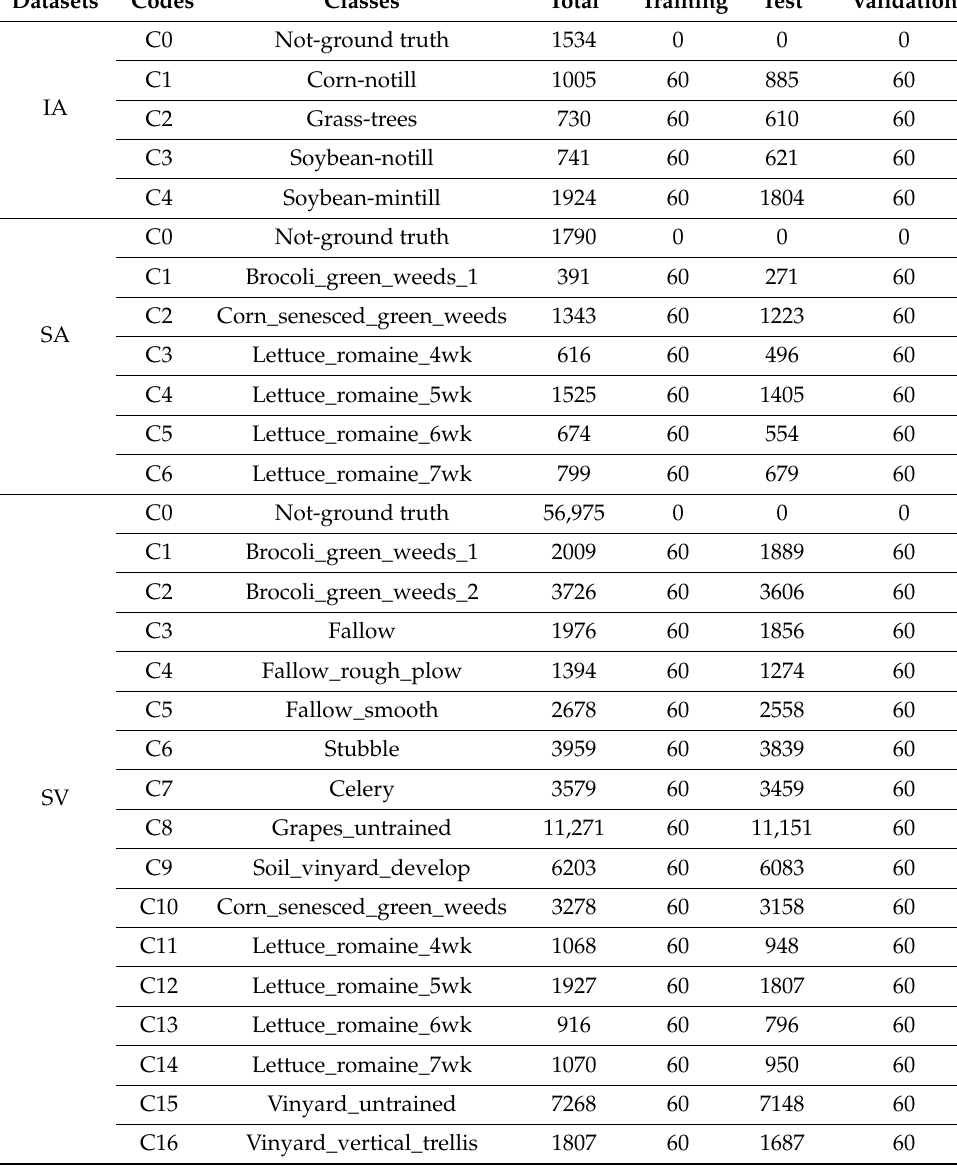
Table 1. The division of ground truth samples for the Indian Pines-A (IA), Salinas Valley-A (SA), Salinas Valley (SV), and Pavia University (PU)